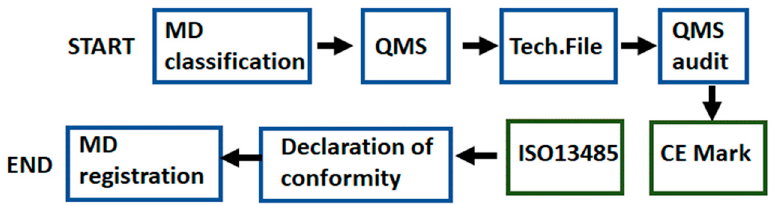
Figure 8. Schematic flow for medical devices to comply with the European regulation and to obtain the CE mark.